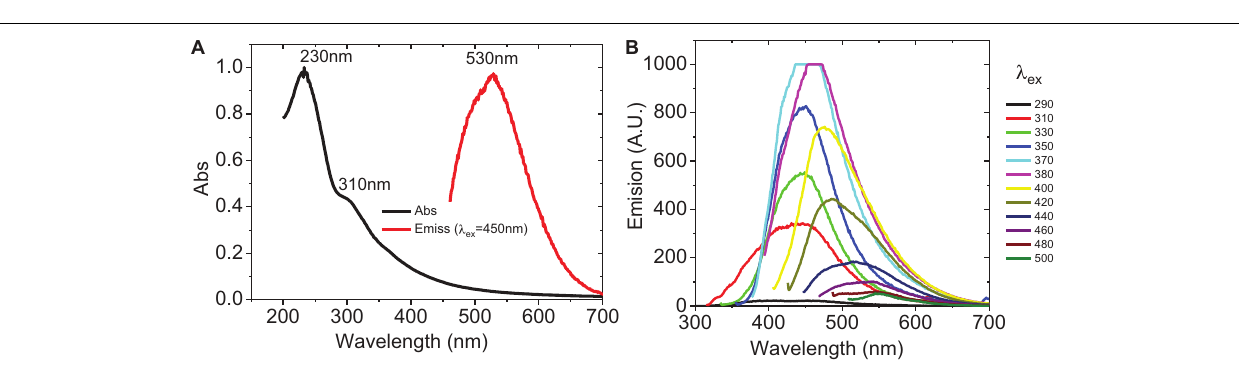
FIGURE 4 | Optical properties of C-DOTS. (A) UV-VIS spectra (black line) and emission spectra (red line). λ ex = 450 nm, λ em = 530 nm. Images above: C-DOTS solution (yellow) without irradiation and C-DOTS emitting light green light when irradiated with 350-nm light. (B) Emission spectra of C-DOTS. Excitation wavelength from 290 to 500 nm (side frame) with their respective emission spectra (same